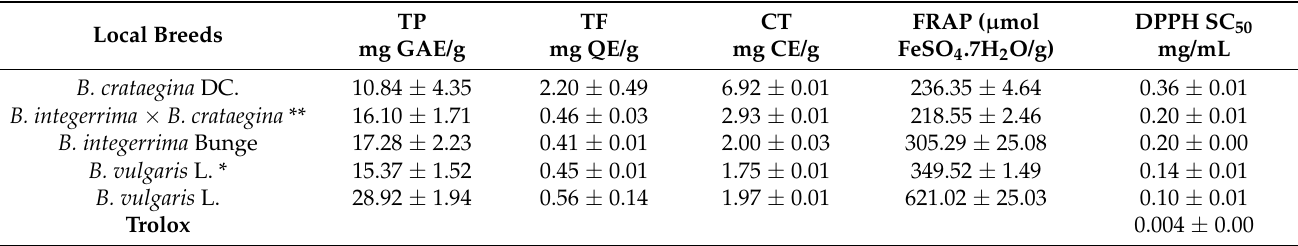
Table 4. Means and standard error (SE), total phenolic content, total flavonoid content, condensed tannin content, and antioxidant activity Berberis spp.